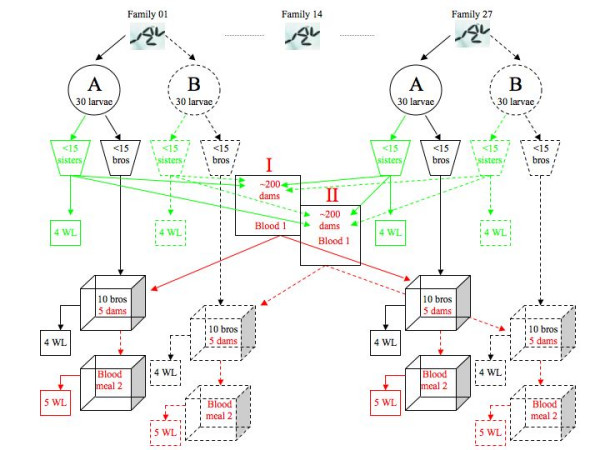
Experimental Design. Experimental design is shown for two of the 27 full sib families (see Methods for full explanation). Each family started with > 60 recently hatched larvae split into two blocks (A and B) of 30 larvae that produced roughly equal numbers (< 15) of brothers (bros) and sisters. For each of the 54 combinations of full sib family*block, four sisters were randomly selected for wing length (WL) measurements and the remaining females were split between two cages (I and II) where the females (now dams) received their first blood meal (Blood 1). For each of the 27 sire families in block A, ten brothers were randomly selected and combined with five randomly selected blood-fed dams from cage I. These mixed-sex swarms were allowed to mate for 24 hours, after which the males were removed and the dams were given their second blood meal. Two days later this process was repeated for the 27 sire families in block B and the blood-fed dams from cage II. For each of the 54 mating cages, the wing length of four randomly selected brothers and all 5 dams were measured. Blocks A and B are shown with solid and stippled lines, whereas brothers, sisters and dams are colour-coded black, green and red.